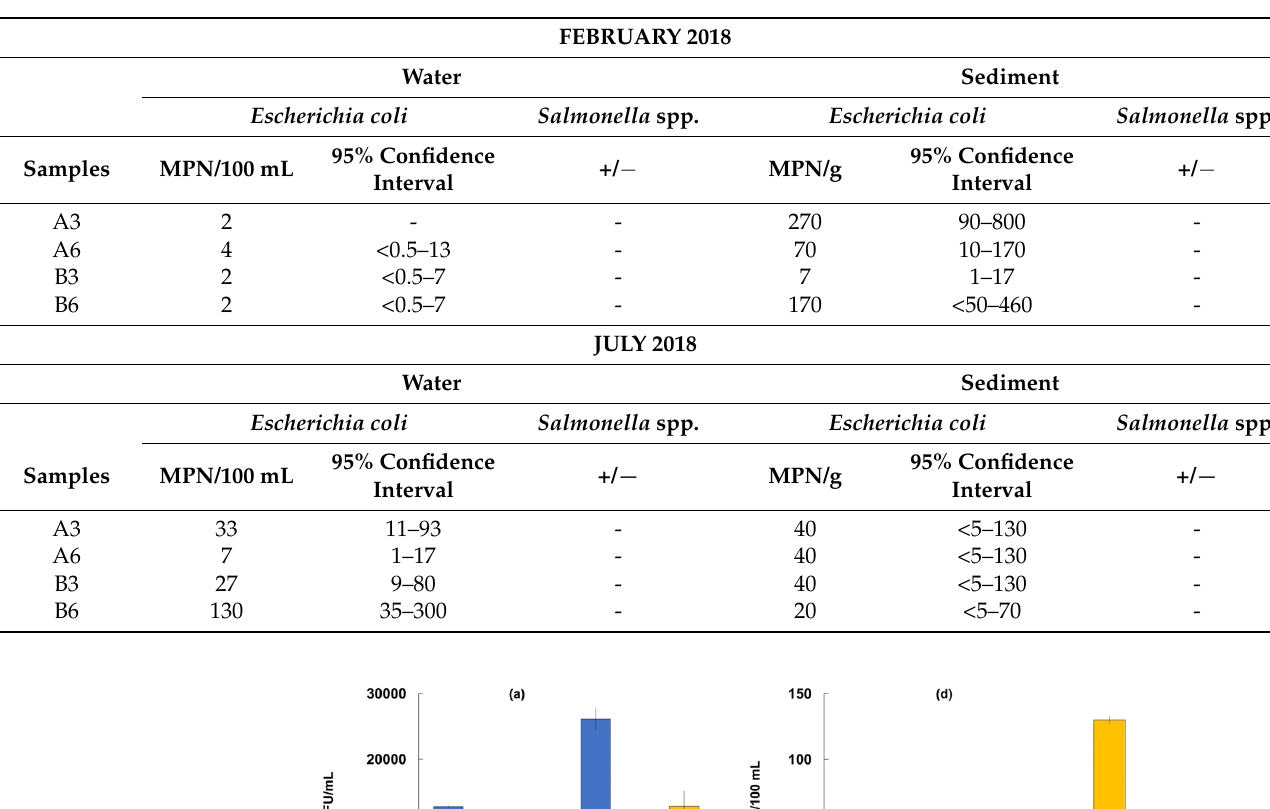
Table 5. Escherichia coli and Salmonella spp. results (+ presence; − absence).